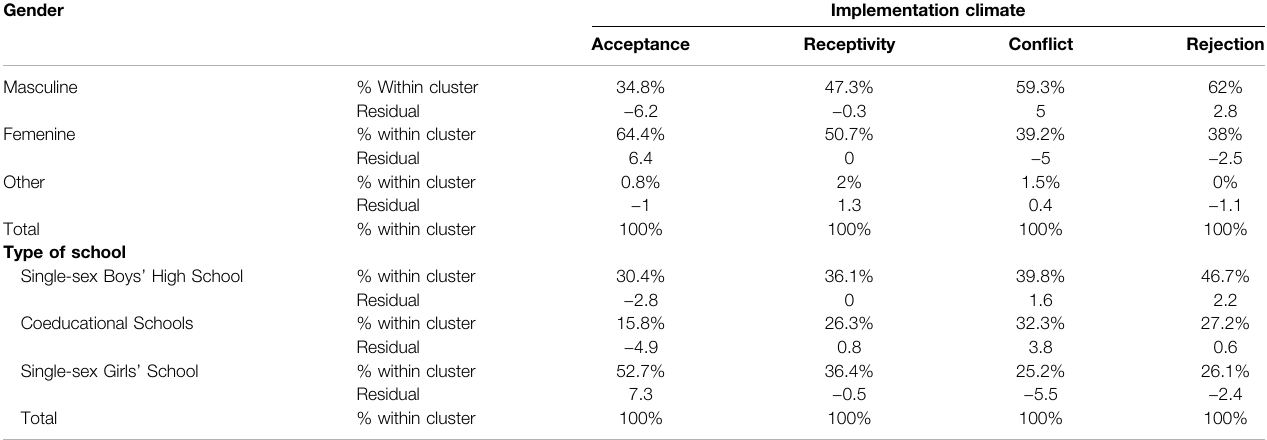
TABLE 4 | Association between implementation climate and participants ’ gender and type of school. Gender Implementation